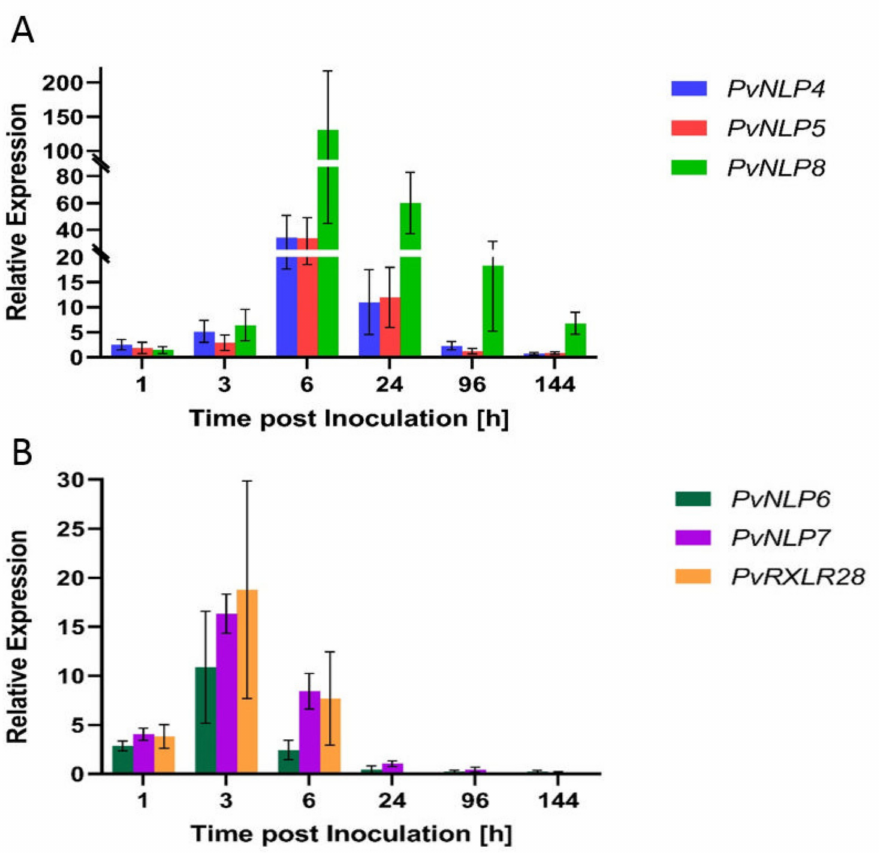
Figure 1. Expression of PvNLP during infection of Vitis vinifera cv. Mueller-Thurgau leaf cells: ( A ) Relative expression of PvNLP4 , PvNLP5 and PvNLP8 . ( B ) Relative expression of PvNLP6 , PvNLP7 and PvRXLR28 . The displayed graphs represent one of four experiments with similar results. Bars are the mean of four technical replicates ± standard deviation